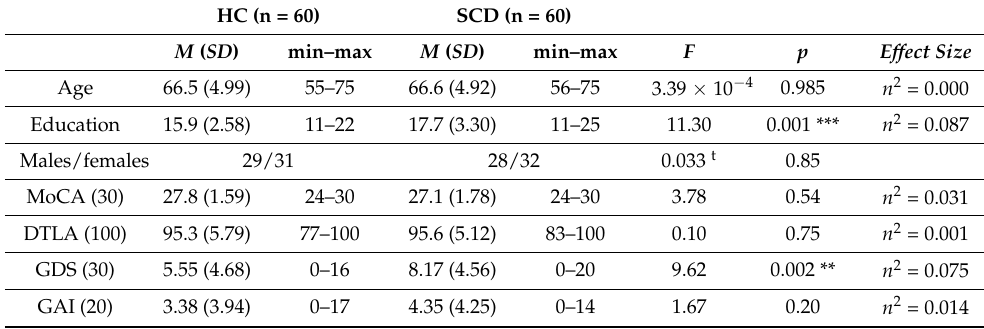
Table 1. The demographic and cognitive characteristics of